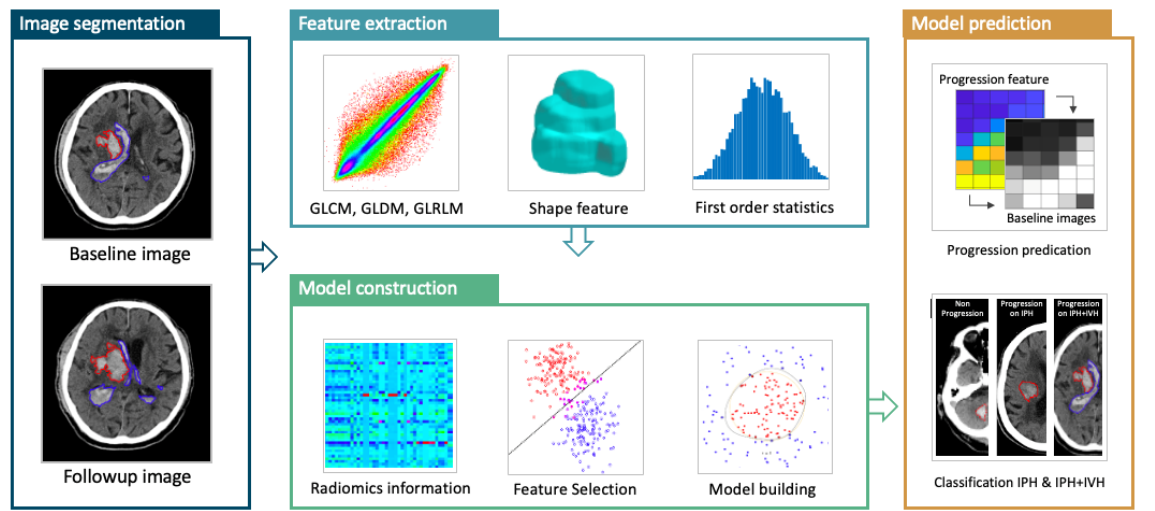
Figure 1. The radiomics analysis flowchart to build the ICH expansion model. The IPH and IVH are segmented by manual tracing of the hematoma at baseline and follow-up CT images. The absolute or percentage volumetric change is calculated to determine whether the patient is an expander or non-expander based on IPH or IPH + IVH. The baseline ROI is used to extract radiomics features, and then the important features are selected using the support vector machine (SVM) algorithm to build the prediction model with the SVM.